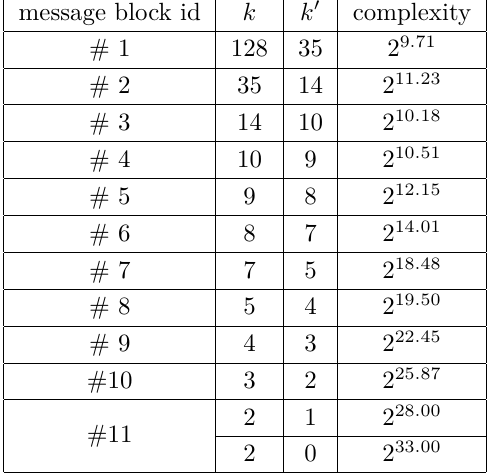
Table 3: A possible iterating process of 3-round Keccak-224 via Iterating Strategy